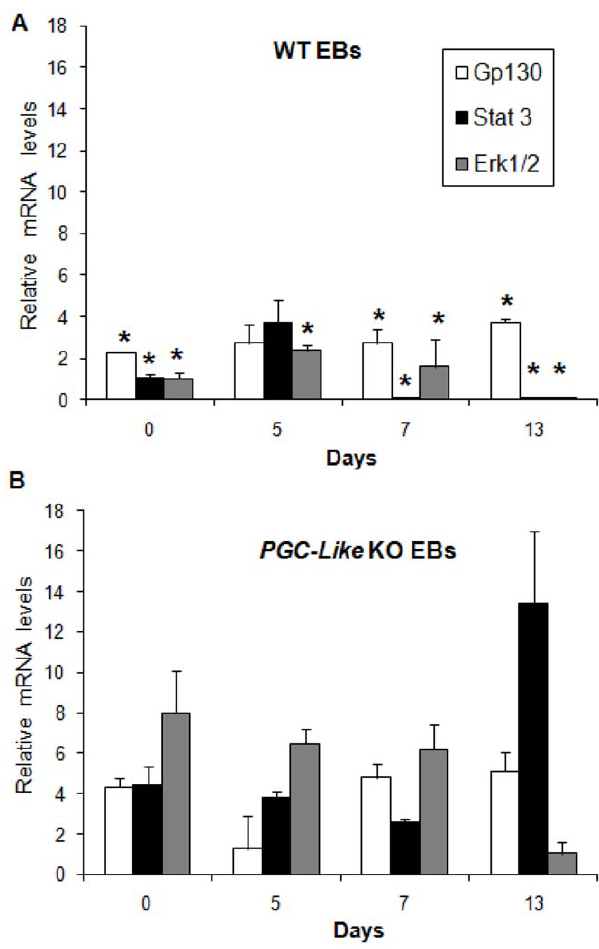
Figure 6. LIF pathway regulation in the WT and Prnp -null cell lines. WT EB mRNA ( A ) and PGC-like KO EB mRNA ( B ) expression patterns of some LIF pathway genes during differentiation (Days 0 [(Stem Cell], 5, 7 and 13). (*indicates significant differences for a particular gene between WT and PGC-like KO EBs (P , 0.05)) (Error bars, s.e.m.).